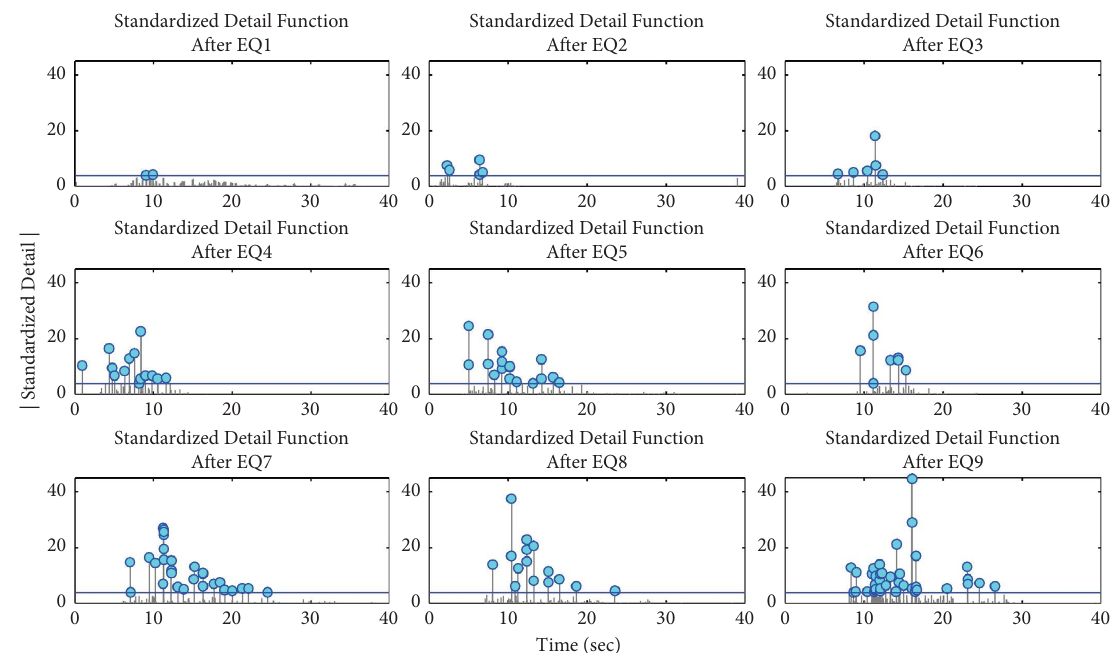
Figure 11: Standardized decomposed details of acceleration response due to all records.